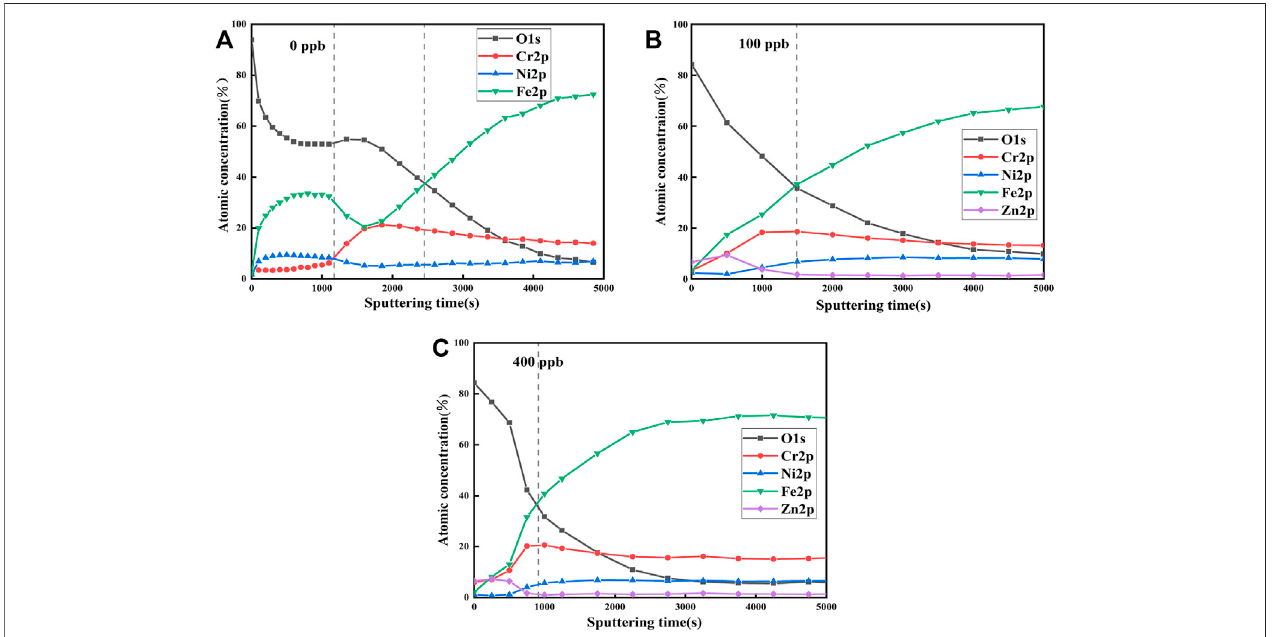
FIGURE 4 | XPS depth analysis of oxide fi lm on 304SS in non-zinc and zinc solutions at 553.15 k for 336 h: (A) 0 ppb (B) 100 ppb (C) 400 ppb.